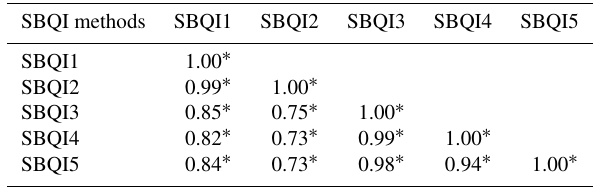
Table 8. Correlation coefficient (Pearson, n − 1) relating five dif- ferent methods used to measure the soil biological quality index of long-term nutrient management adopted soils of three different agroecological zones and farmers’ soils of Tamil